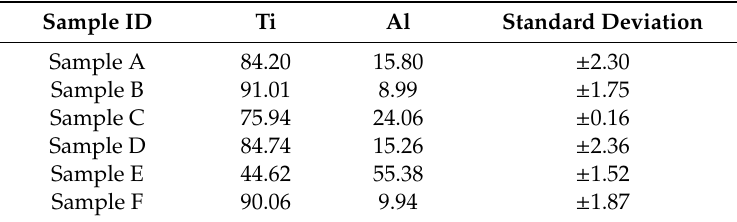
Table 3. Chemical composition (at.%) of the as-built samples.